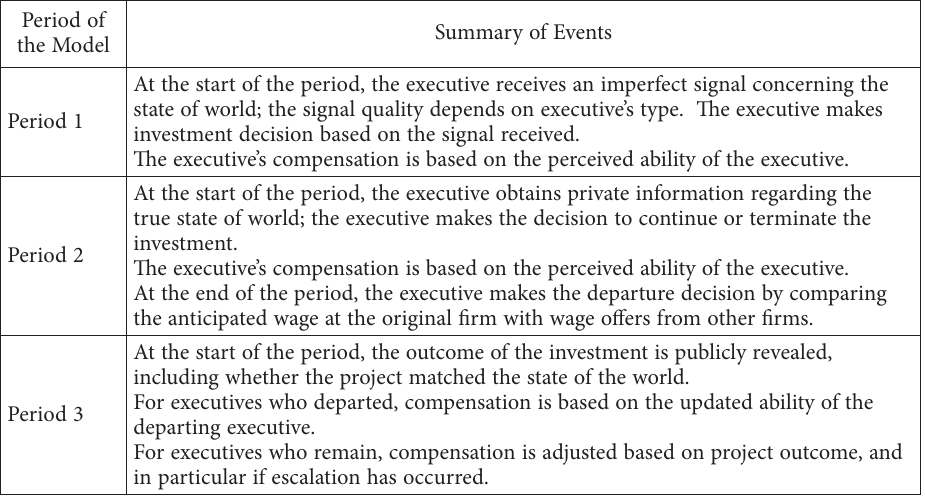
Table 1. Timeline of the